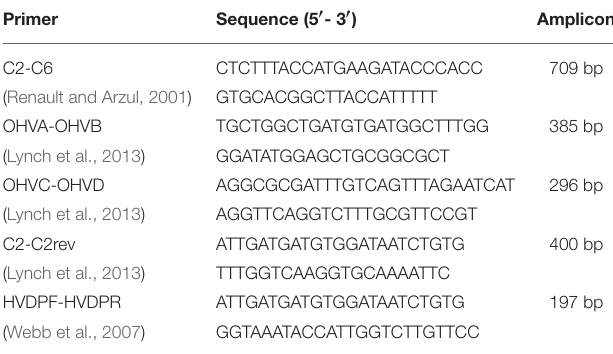
TABLE 1 | List of primers used in this